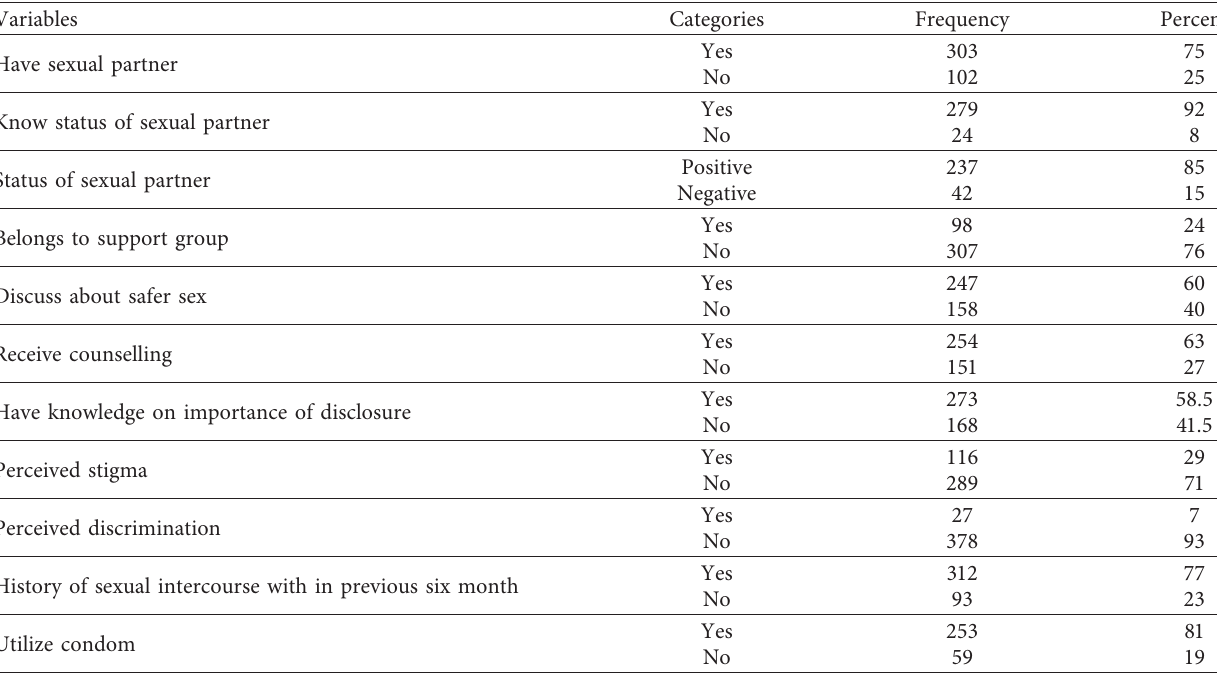
Table 3: Individual and psychosocial factors of adult ART patients attending public health facilities of Butajira town, Southern Ethiopia, 2019 ( n �